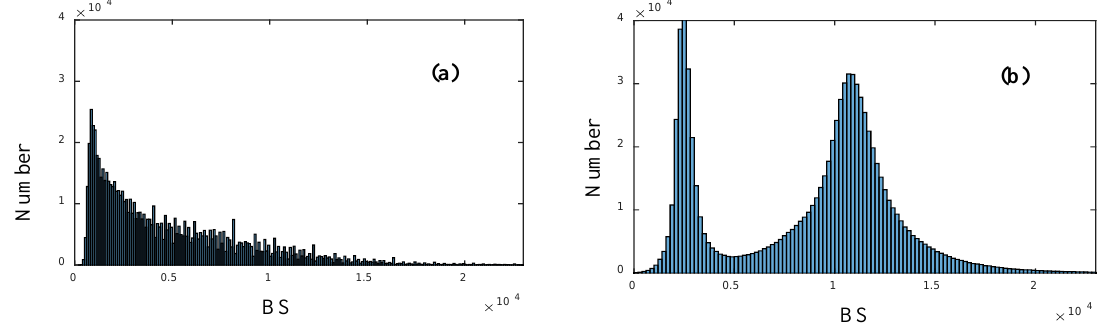
Figure 12. ( a , b ) Histograms of the raw BSs and those corrected with the proposed method. In the above experiment, the seabed consisted of only two sediments. A segment of SSS data with six types of sediments (i.e., bedrock, gravel, coarse sand, medium sand, fine sand, and silt) was extracted from the measuring data to analyze the performance of the proposed method when correcting an SSS image with various sediments (Figure 13a). The radiometric distortion in the SSS data was corrected with the proposed method. First, the SSS data were converted to an angle–BS image (Figure 13b), normalized with the z-score, and classified with the k -means++ algorithm (Figure 13c). Second, the average angle–BS curves of the six sediments were extracted (Figure 13d), and radiometric distortion was corrected (Figure